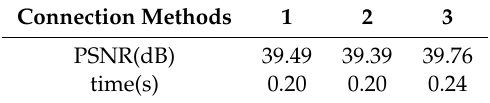
Figure 7. Loss values with different connection methods with scale factor ×2. Table 3. PSNR and cost time consumption with different connection methods with scale factor ×2.